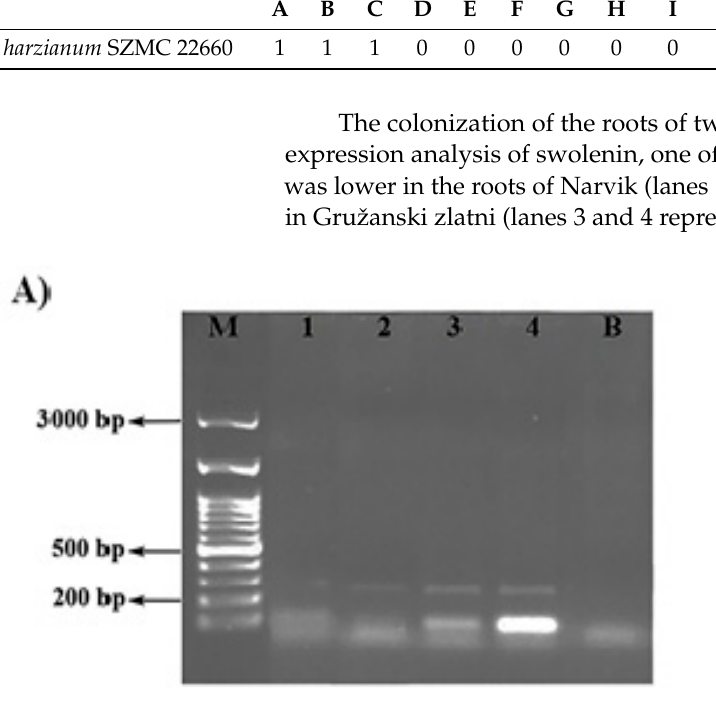
Figure 1. Expression of the swolenin gene ( A ) and β -actin reference gene ( B ) in the roots of tomato variety Narvik (1, 2) and Gružanski zlatni (3, 4). B refers to blank and M referes to the 100 bp DNA Ladder H3 RTU 50 µ g/500 µ L ( A ) and 50 bp DNA Ladder MWD50 50 µ g/500 µ L ( B